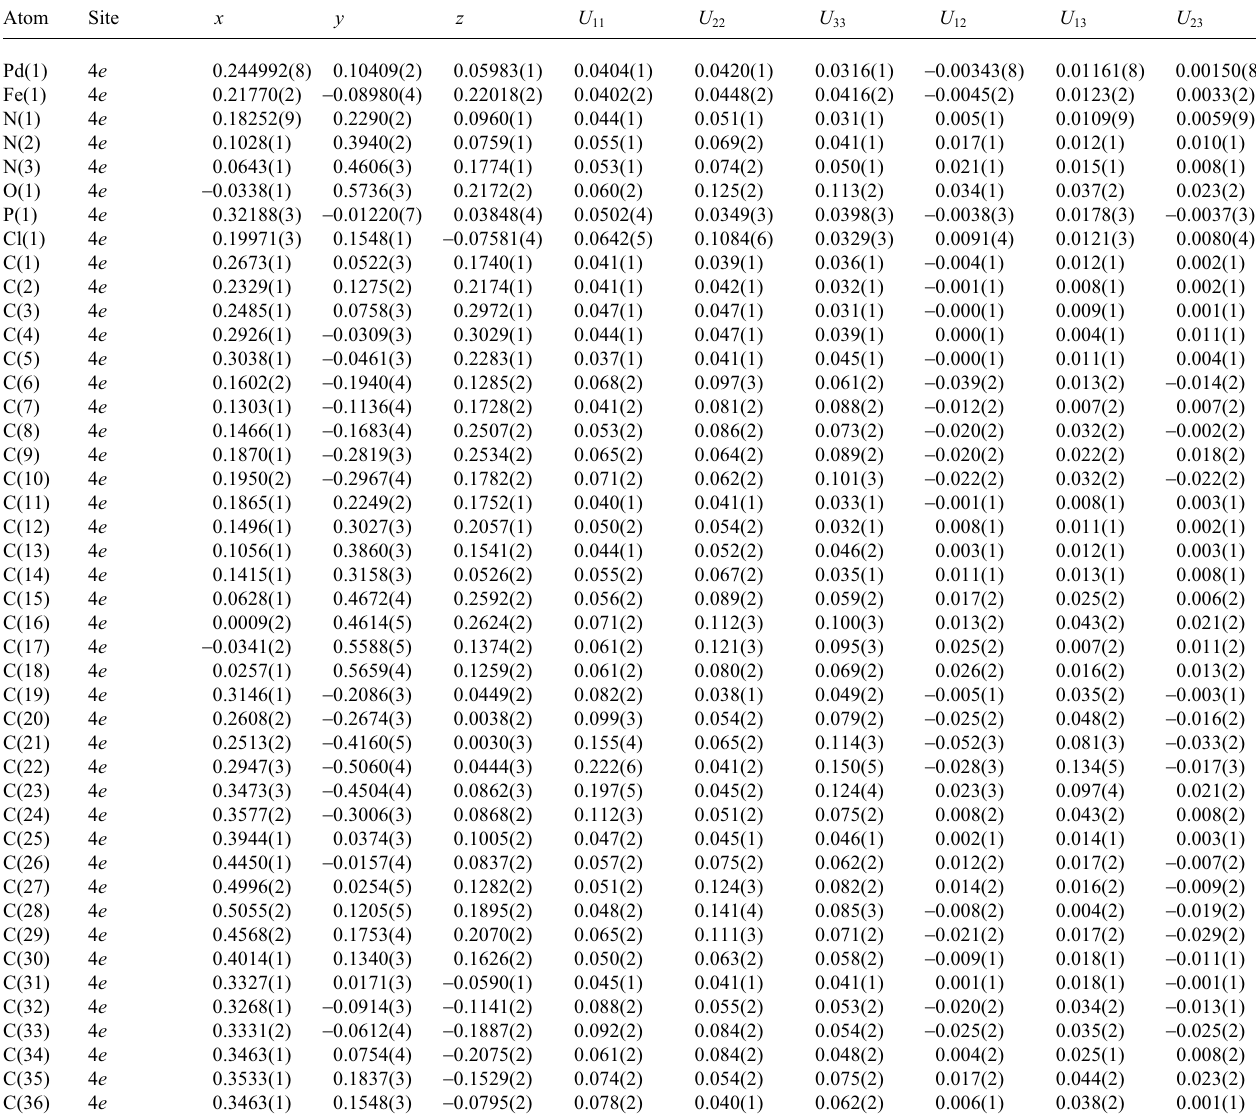
Table 3. Atomic coordinates and displacement parameters (in Å 2